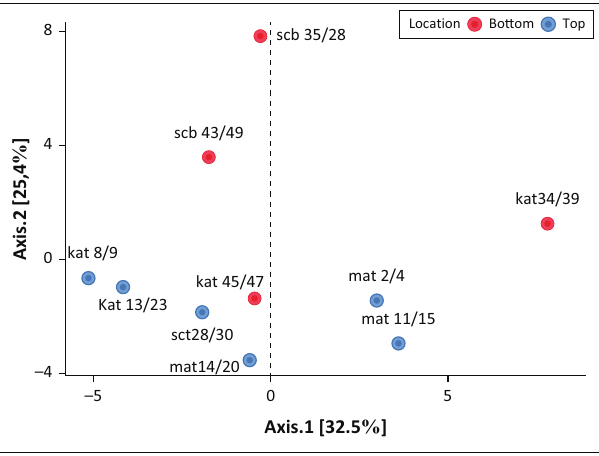
FIG URE 6: Principal coordinates analysis of the functional capacity for the rhizosphere microbiome for Kyphocarpa angustifolia and Sida cordifolia from the Sterkspruit site (bottom) and K. angustifolia , Melhania acuminata and S. cordifolia from the Clovelly site